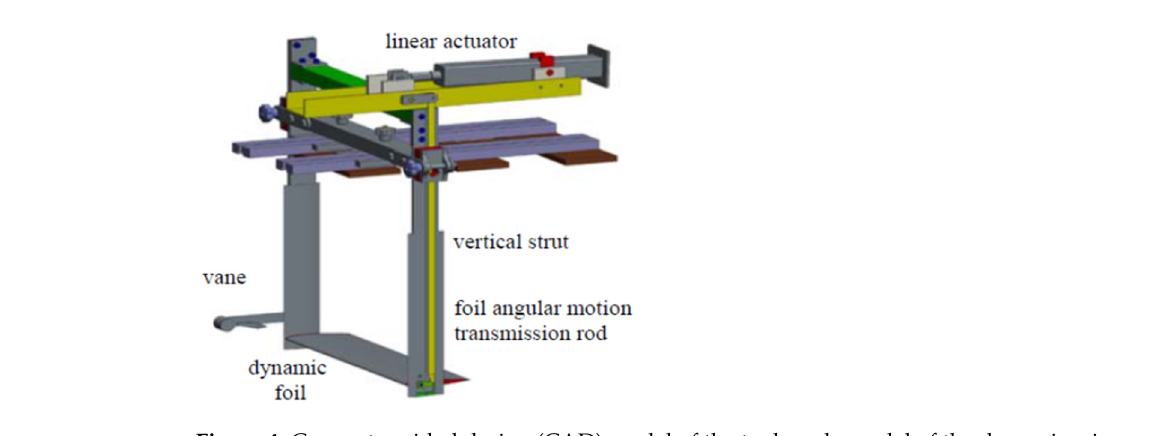
Figure 4. Computer-aided design ( CAD) model of the tank-scale model of the dynamic wing used for testing.